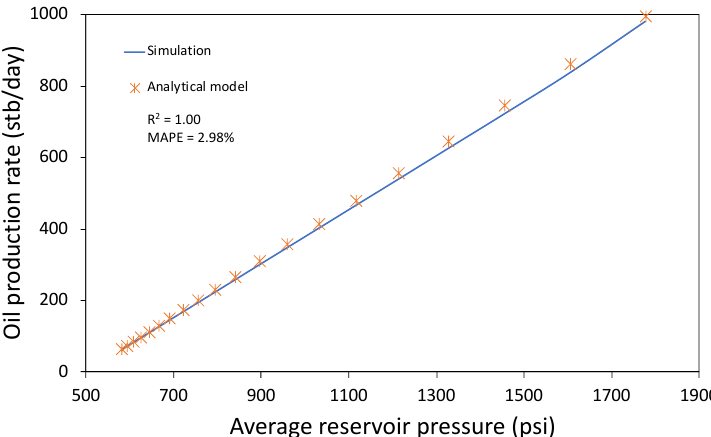
Figure 4. Comparison between the model-predicted production rate and the simulation results (Case 1).